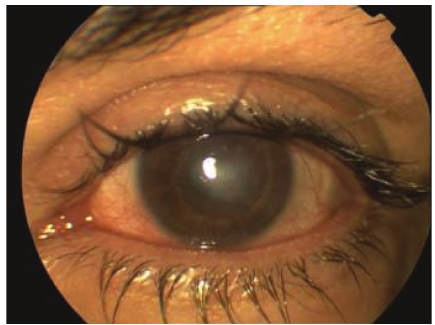
Figure 6: Clinical picture of the left eye 7 months after LASIK. There is minimal conjunctival injection and vascularized corneal